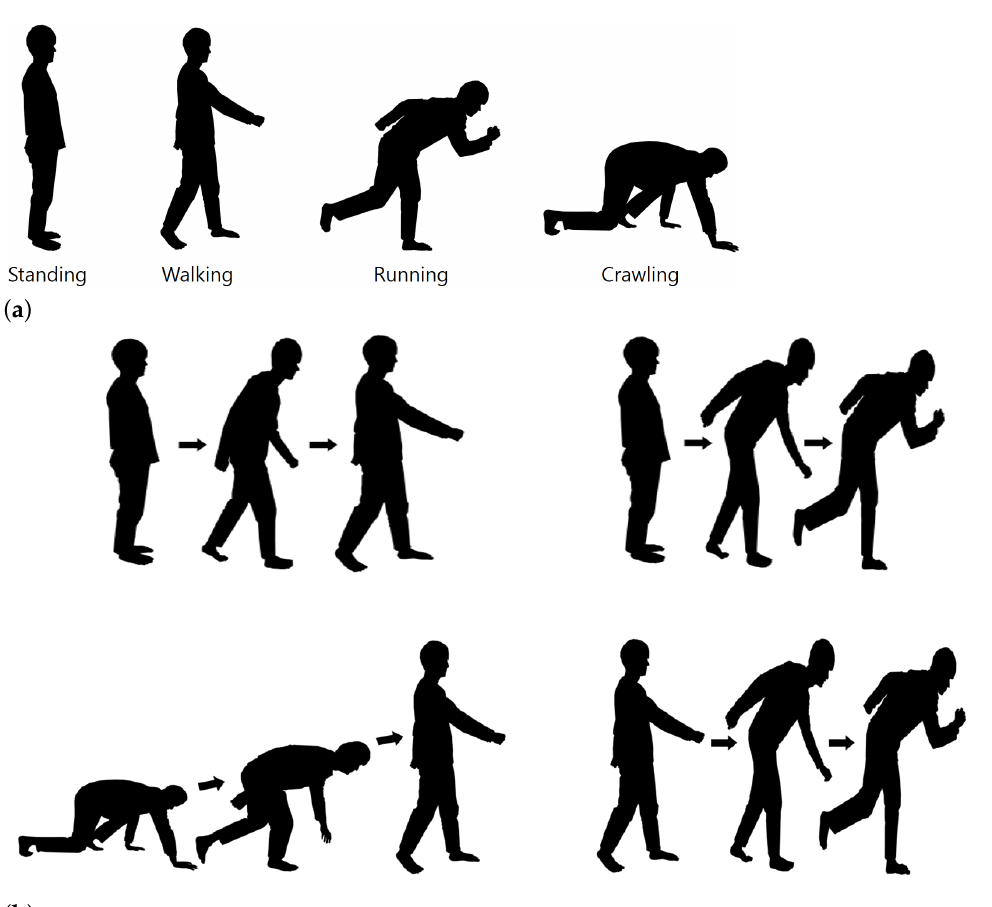
Figure 4. Examples of motions: ( a ) Performing only one motion. ( b ) Performing two motions in a